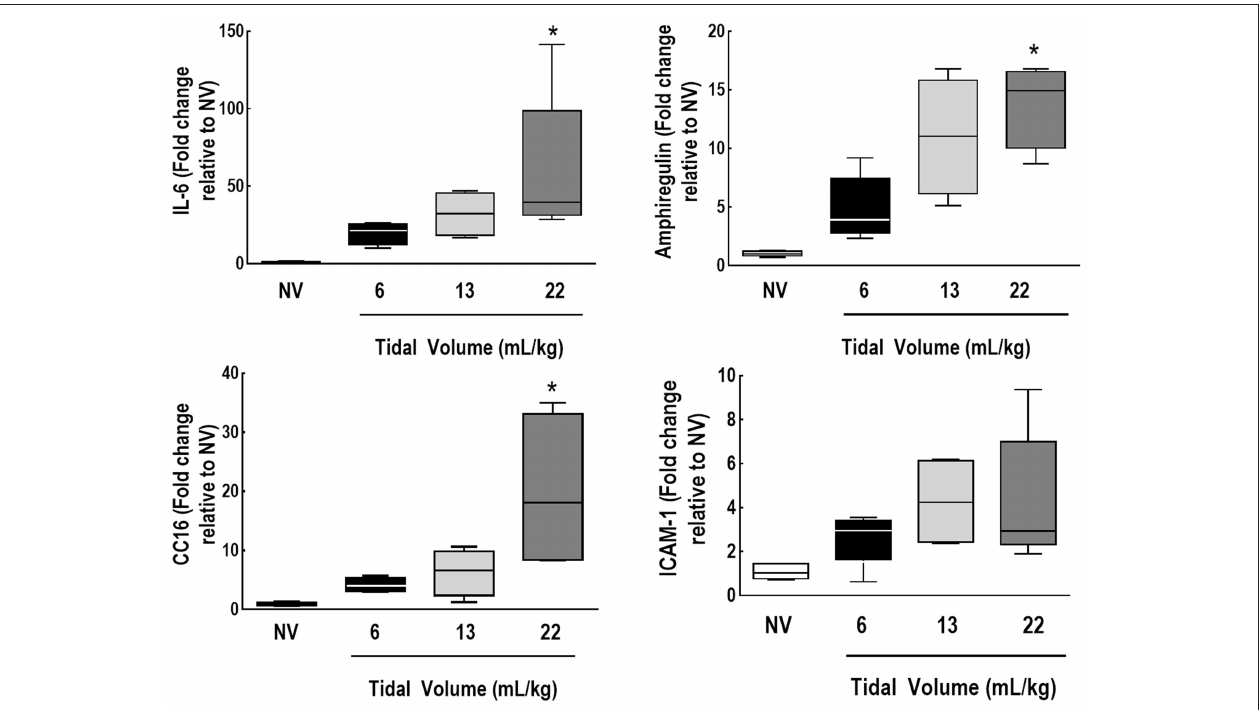
FIGURE 5 | Expression of biomarkers associated with inflammation, alveolar stretch, and epithelial and endothelial cell damage. Real-time polymerase chain reaction analysis of markers of inflammation [interleukin (IL)-6], alveolar stretch (amphiregulin), and epithelial [club cell protein (CC)16] and endothelial cell damage [intercellular adhesion molecule (ICAM)-1]. Relative gene expression was calculated as the ratio of average gene expression levels to reference gene ( 36B4 ) expression and presented as fold change relative to non-ventilated animals (NV). Values are medians and interquartile ranges of 7 rats in each group. Comparisons among all groups were done by the Kruskal-Wallis test followed by Dunn’s test ( p < 0.05). *vs. V T = 6 mL/kg ( p <